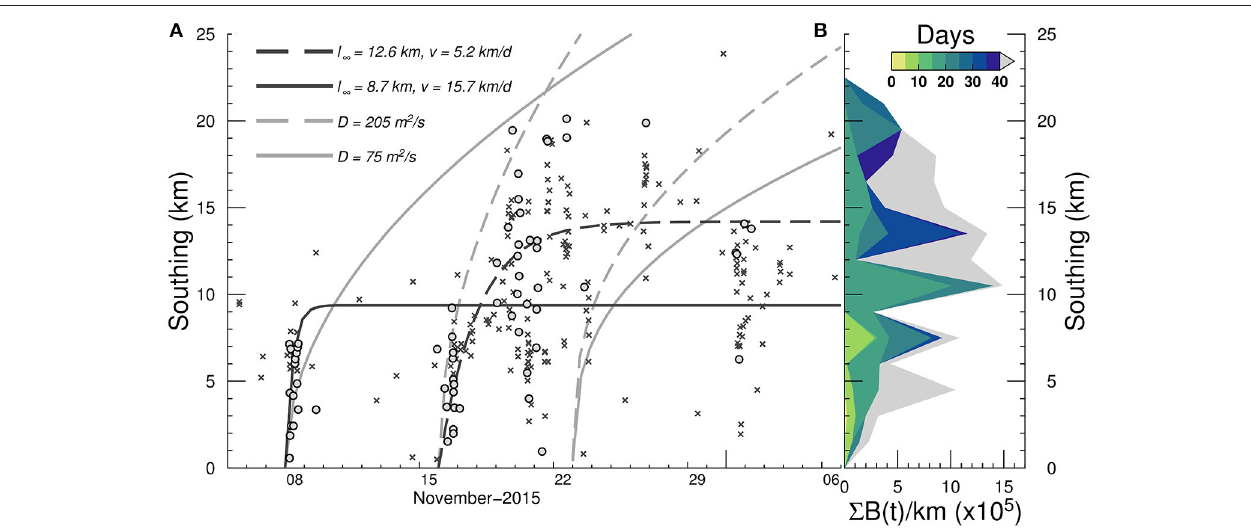
FIGURE 9 | (A) Same as in Figure 8 but restricted to the time between 5 November and 7 December 2015 to highlight the earthquake migration and the fit of the models. Shaded circles and cross symbols are the same as in Figures 3 , 8 . Black solid line is the fit of the dike model from 8 November to 22 November, black dashed line is the dike model fit from 16 November to 22 November. Solid and dashed gray lines are the fit of the pore-pressure diffusion model, i.e., front and back-front, performed on the same time span as the two dike models. The 95% confidence levels for the parameter fits are given in Supplementary Table S2. (B) Distribution of cumulative Benioff strain P B(t) per unit distance calculated in 1.5km bins and cumulated every 3-day window starting from 8 November 2015 and color-coded